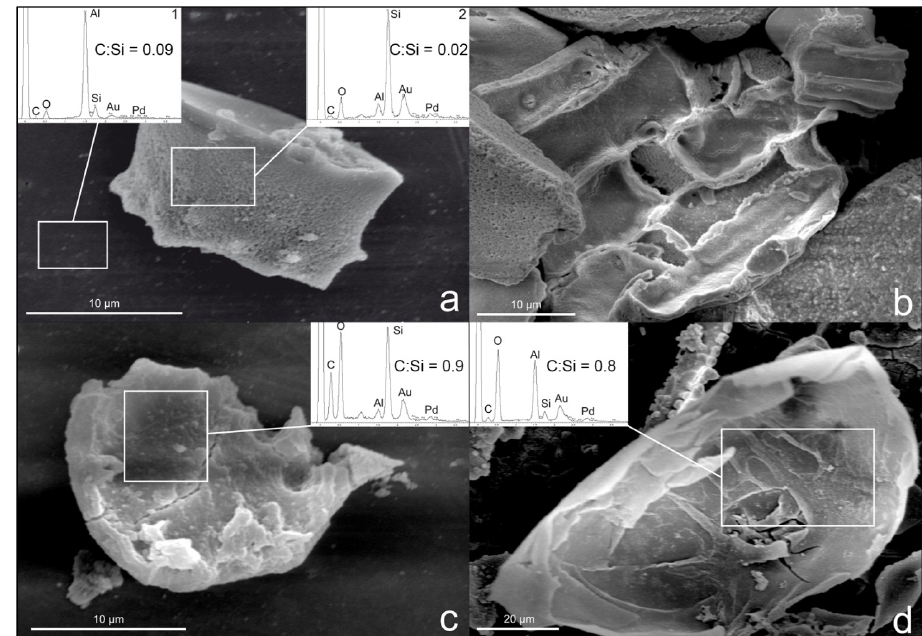
Fig. 2. Phytolith concentrates from Grass 1 and MN samples extracted at CEREGE and at the SSAL laboratory at the University of Wisconsin- Madison, respectively (Santos et al., 2010a). Note that phytoliths obtained from these samples yielded apparent 14 C-AMS ages of 2005 ± 45 (UCIAMS45448), 2310 ± 200 (UCIAMS 45449), 2520 ± 690 (UCIAMS 45450) and 5000 ± 140 (UCIAMS49704) yr BP, whereas bulk biomass and atmospheric CO 2 from the growth sites gave contemporary 14 C values (Table 2). SEM images and EDS spectra reveal the following: characteristic phytolith types such as the rondel type (a) and cuticle-like morphologies (b) , here from Grass 1, are present in the concentrates. These show semi-quantitative C:Si peak area ratios (a-2) lower than or close to the ratio measured on the Al sample holder (a-1) . Other (non-phytolith) organic particles are however present in both the Grass 1 (c) and MN (d) concentrates, and these show much higher C:Si ratios.